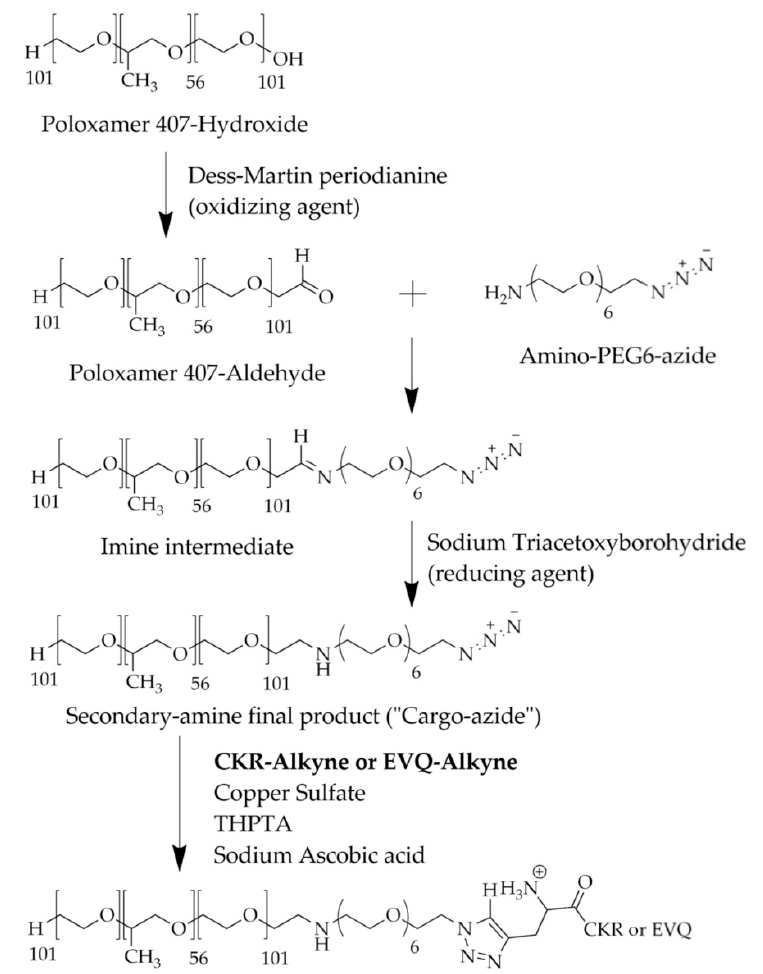
Figure 6. Scheme of cargo azide (CA) and CA conjugated peptide synthesis.